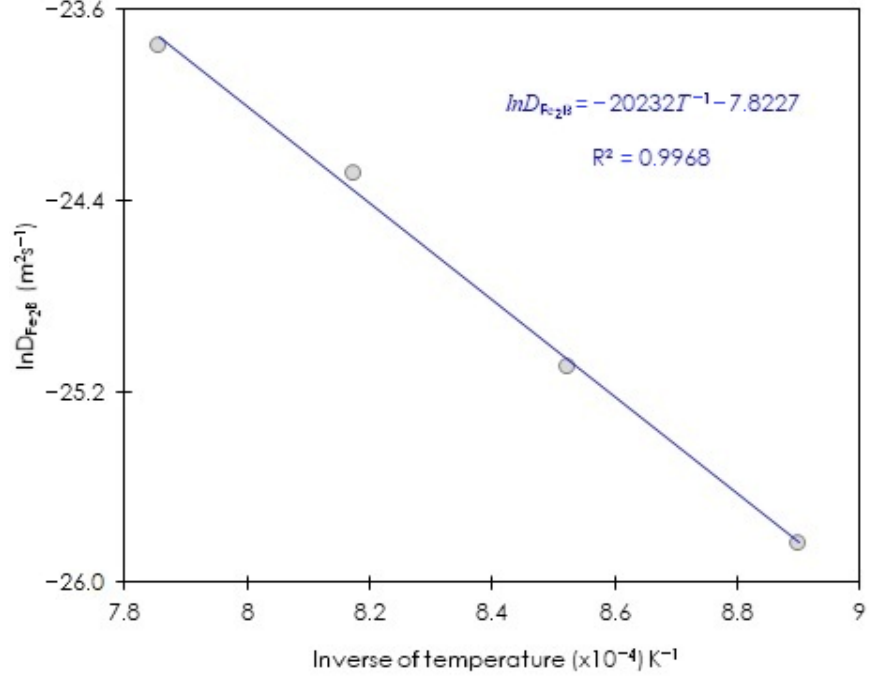
Figure 16. Arrhenius relationship between the estimated boron diffusivity in Fe 2 B and the process temperature by the second approach (the integral diffusion model).